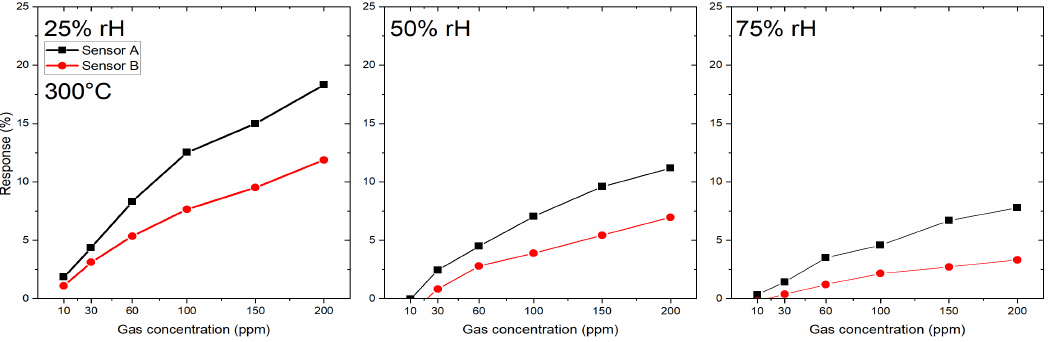
Figure 6. Response of SnO 2 nanowires-based SB sensors (A and B) towards CO at 300 ◦